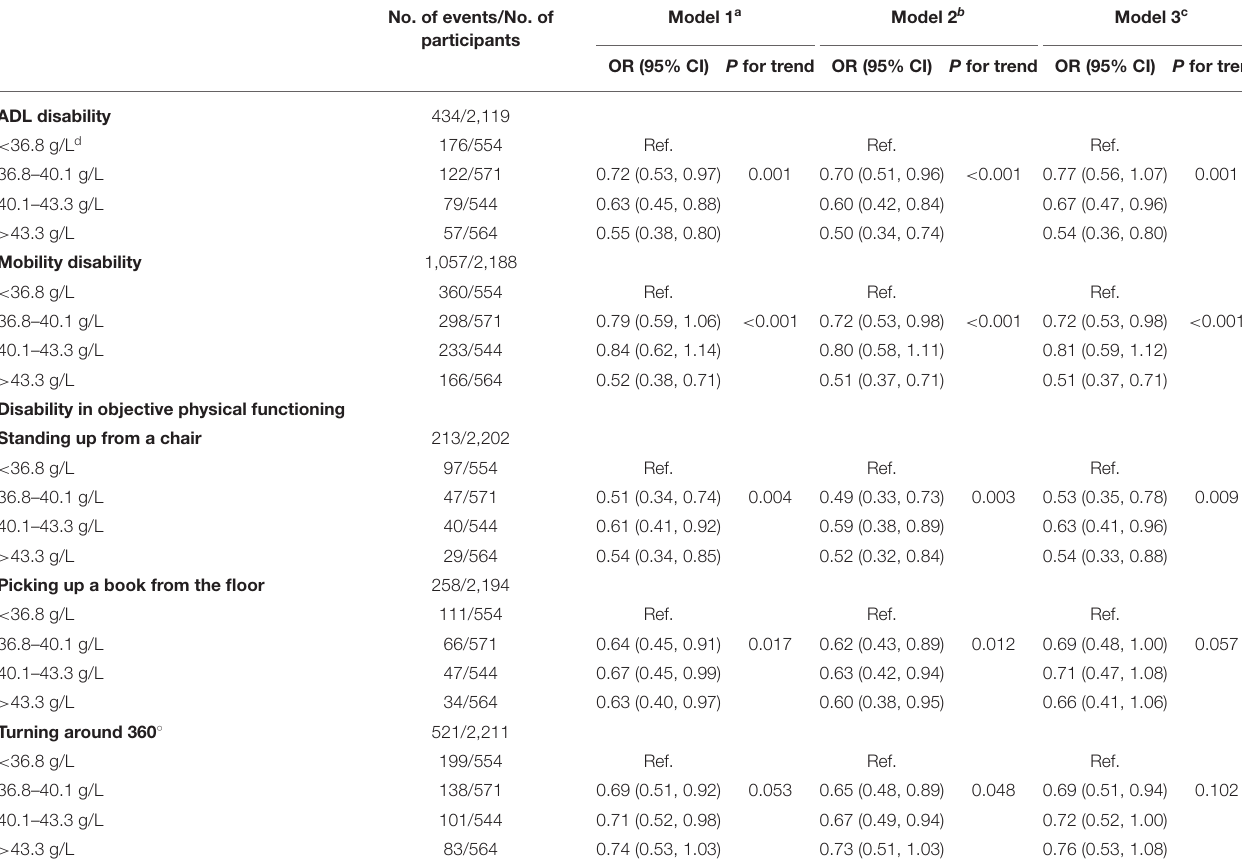
TABLE 2 | Associations of serum albumin level with ADL disability, mobility disability, and disability in objective physical